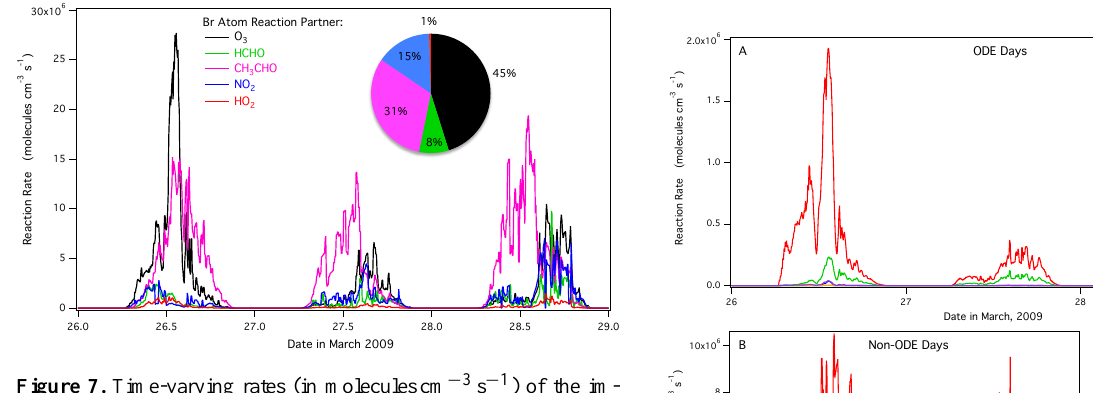
Figure 7. Time-varying rates (in moleculescm − 3 s − 1 ) of the im- portant Br atom sinks during ODEs (O 3 <5ppbv). The inset pie chart represents the fractional importance of each sink calculated as the median value across the 3 days shown. Time is expressed in Alaska Standard Time.